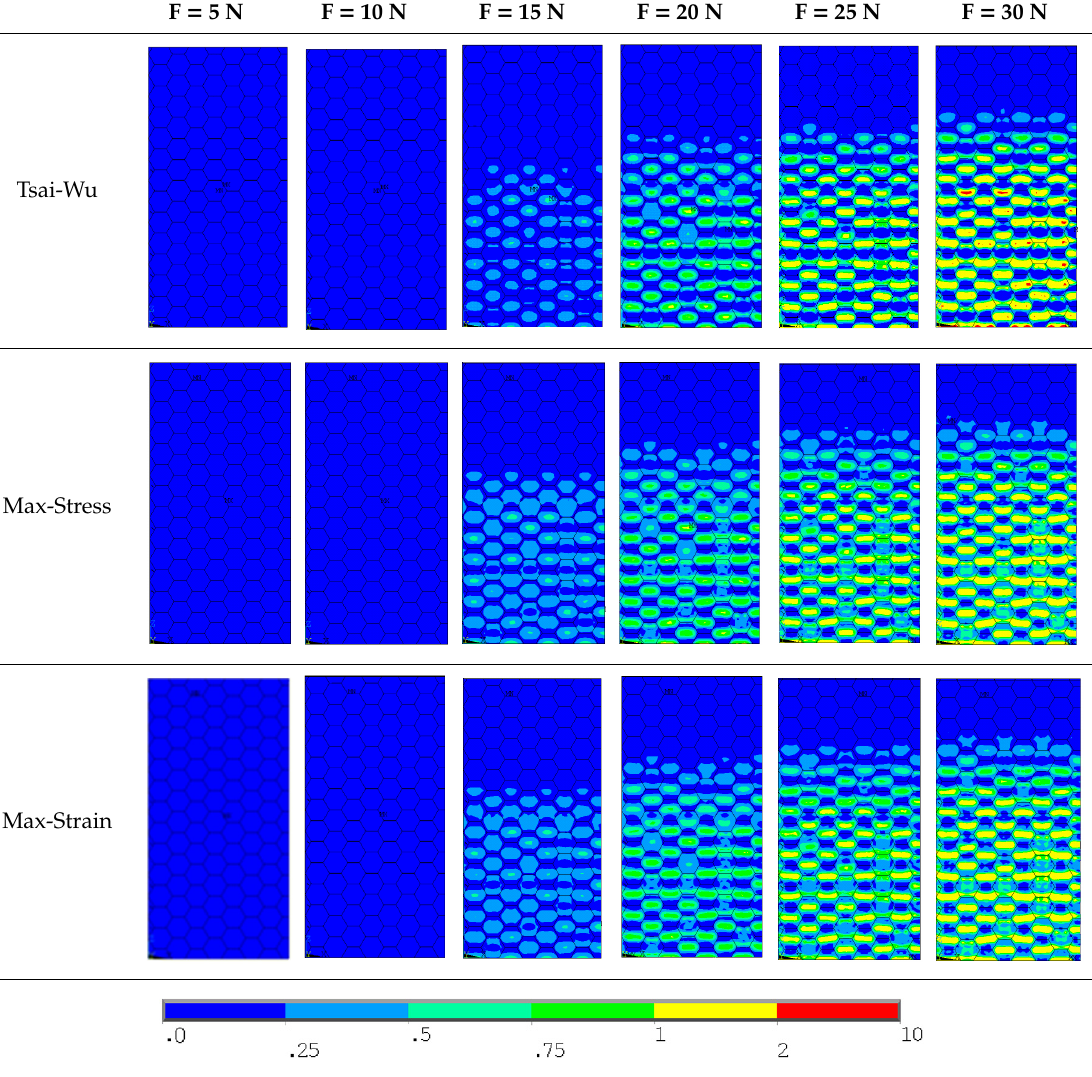
Table 8. Maps of criteria index for Model 1.2 CD R. F = 5 N